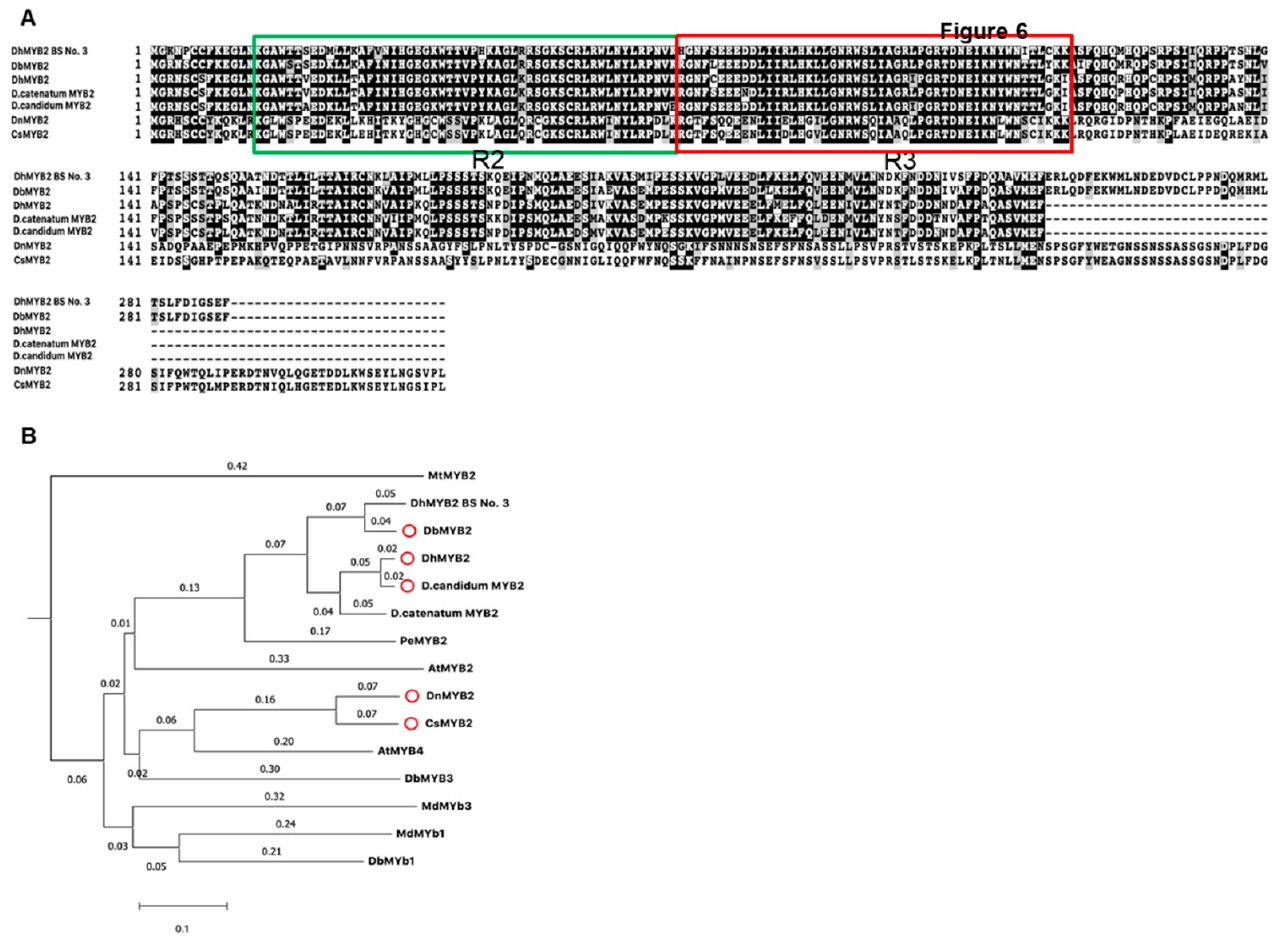
Figure 7. Sequence alignments and phylogenetic tree of DbMYB2 from orchids with known R2R3-MYBs domain. ( A ) Alignments of the full-length deduced amino acid sequences of DbMYB2 with other R2R3-MYBs present in other orchids. ( B ) Phylogenetic relationship of DbMYB2 with known anthocyanin MYB regulators from other orchid